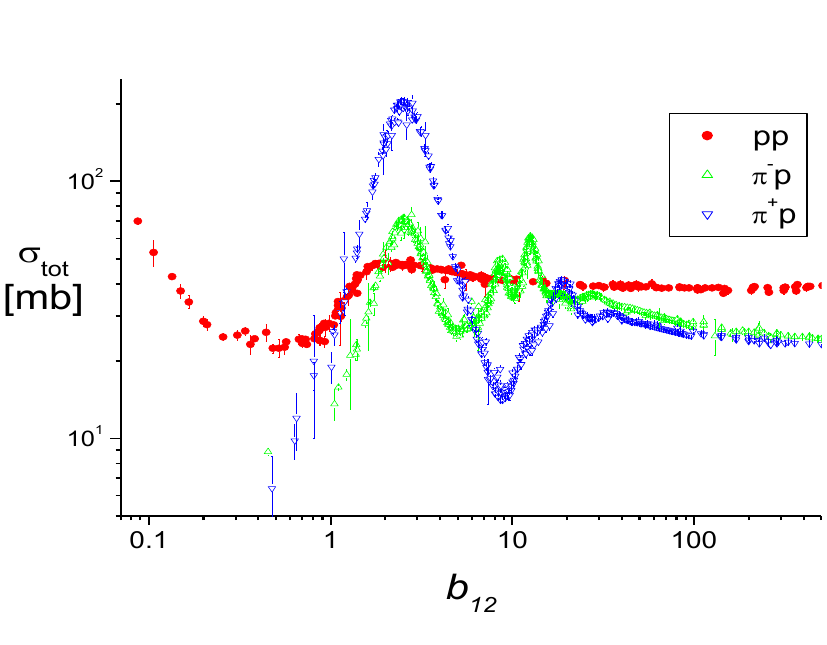
Figure 2. Total cross section of particle production as a function of b ik .